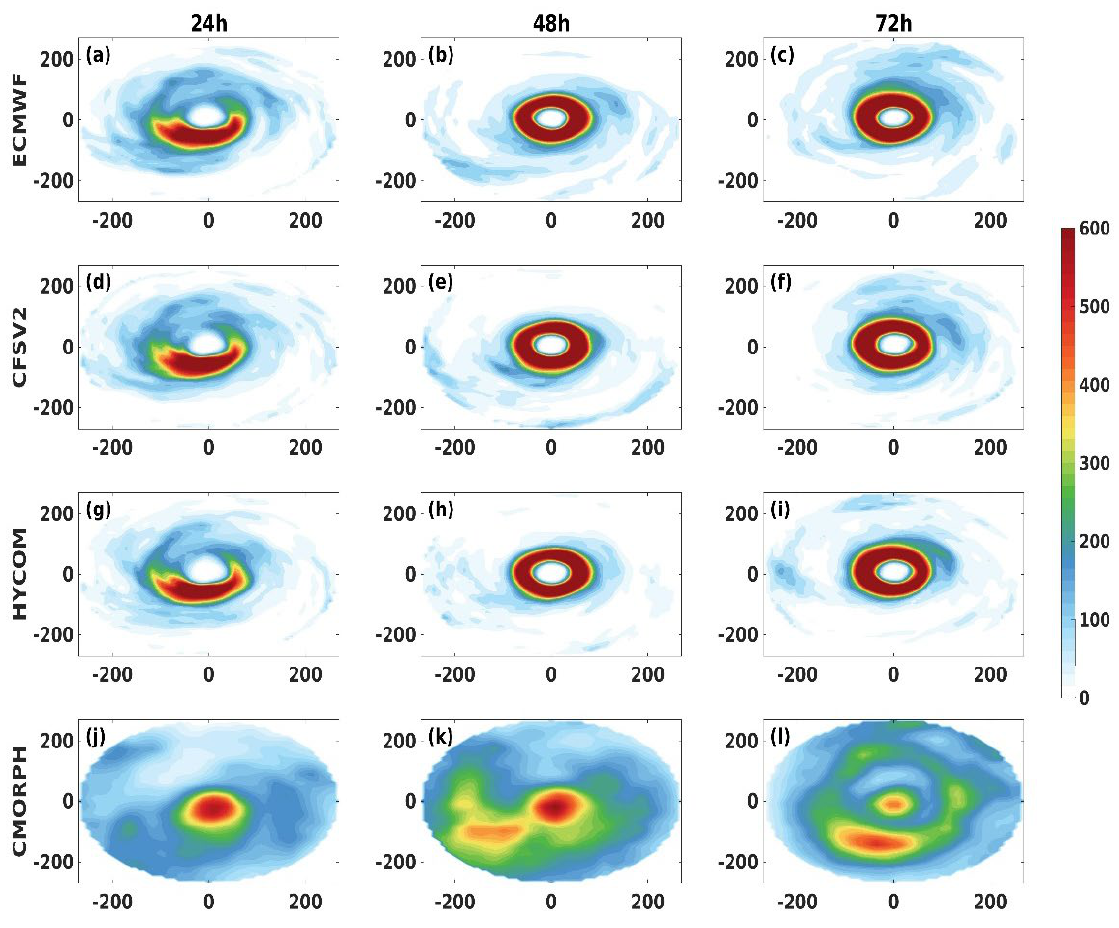
Figure 3. Radial distribution (270 km) of the 24 h accumulated rainfall (mm) obtained from the experiments (( a – c ) ECMWF, ( d – f ) CFSV2, and ( g – i ) HYCOM) and from CMORPH ( j – l ).